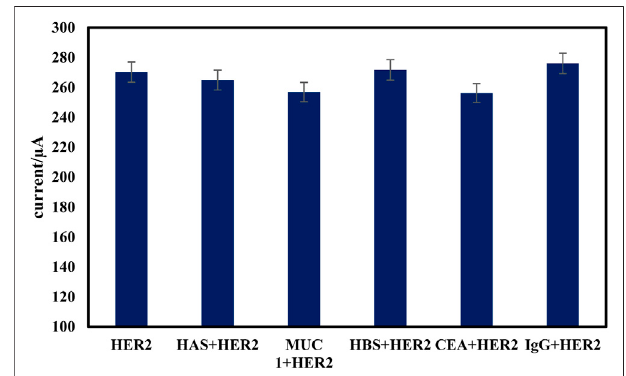
FIGURE 8 | Speci fi city of the proposed electrochemical immunosensor. The amperometric signal changes of the immunosensor to 10 ng/ml HER2 and in presence of 100 ng/ml CEA, HSA, HBS, and